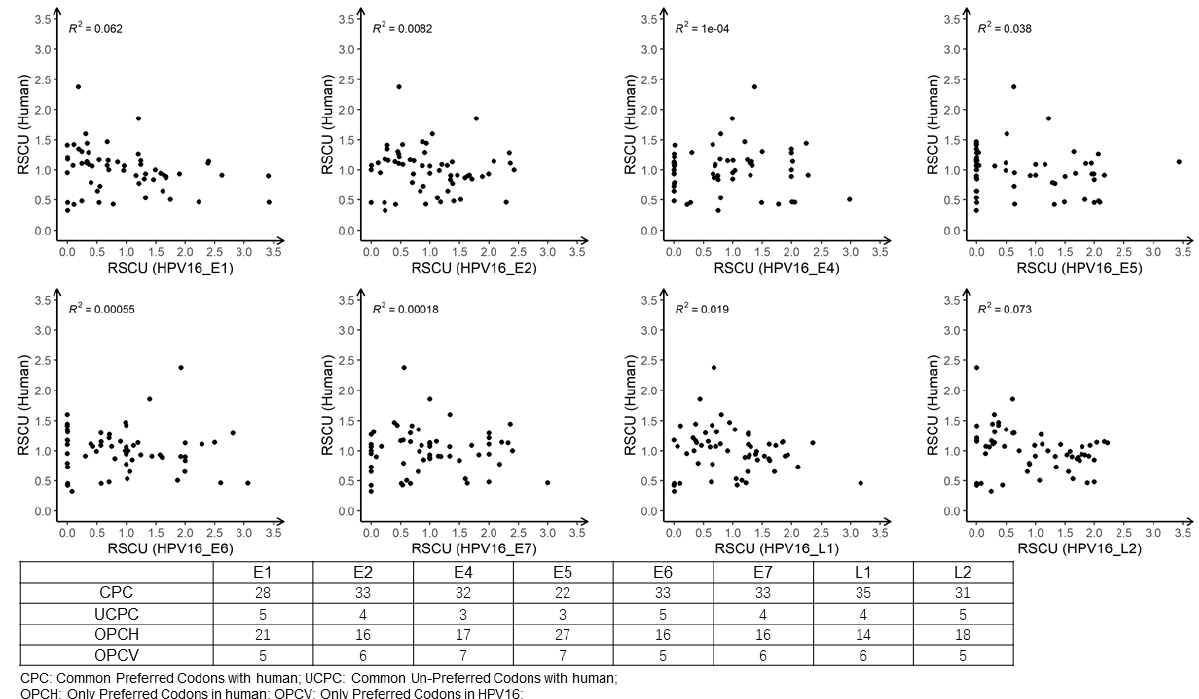
Figure 6. Pairwise correlation analysis of RSCU for 59 codons in eight HPV16 ORFs versus those of humans. The R-squared values of linear regression analysis are shown. The embedded table denotes the number of commonly preferred (RSCU ≥ 0.6) codons and unpreferred (RSCU < 0.6) codons for HPV16 and human genes, and the number of preferred codons in humans but unpreferred in HPV16 and preferred codons in HPV16 but unpreferred in humans.